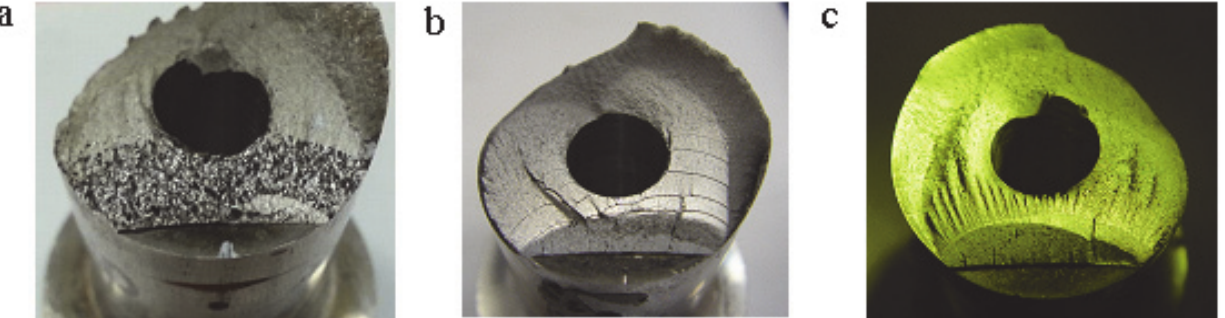
Figure 3: Fracture surface of the hollow specimens at different temperatures: (a) -60°C, (b) +23°C, (c)